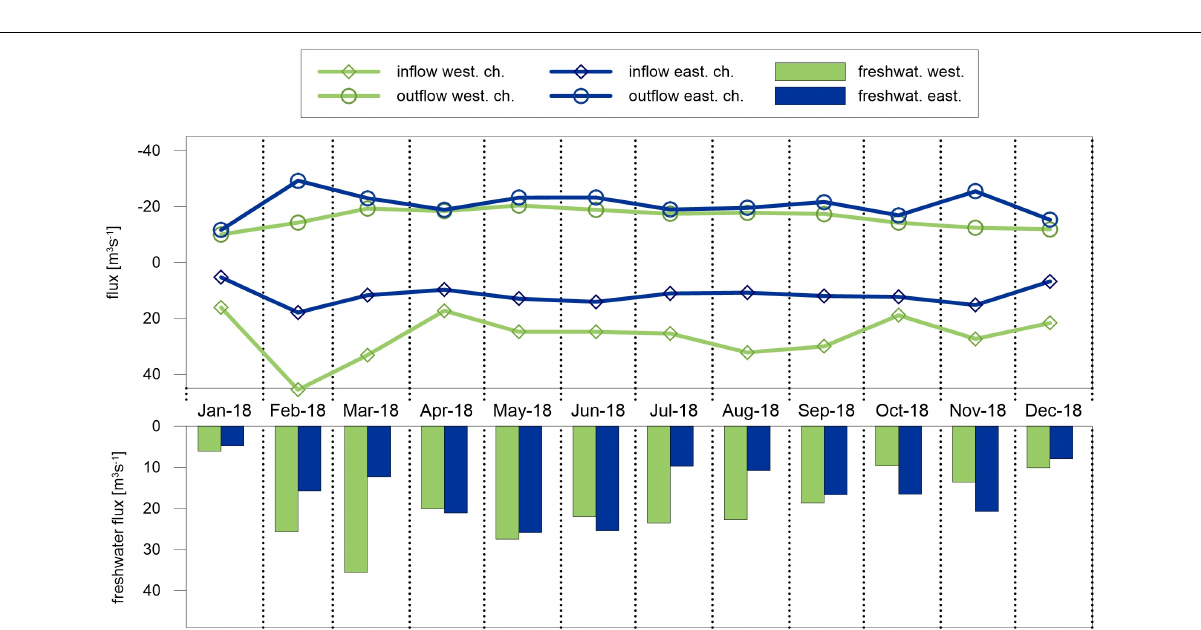
Frontiers in Marine Science |